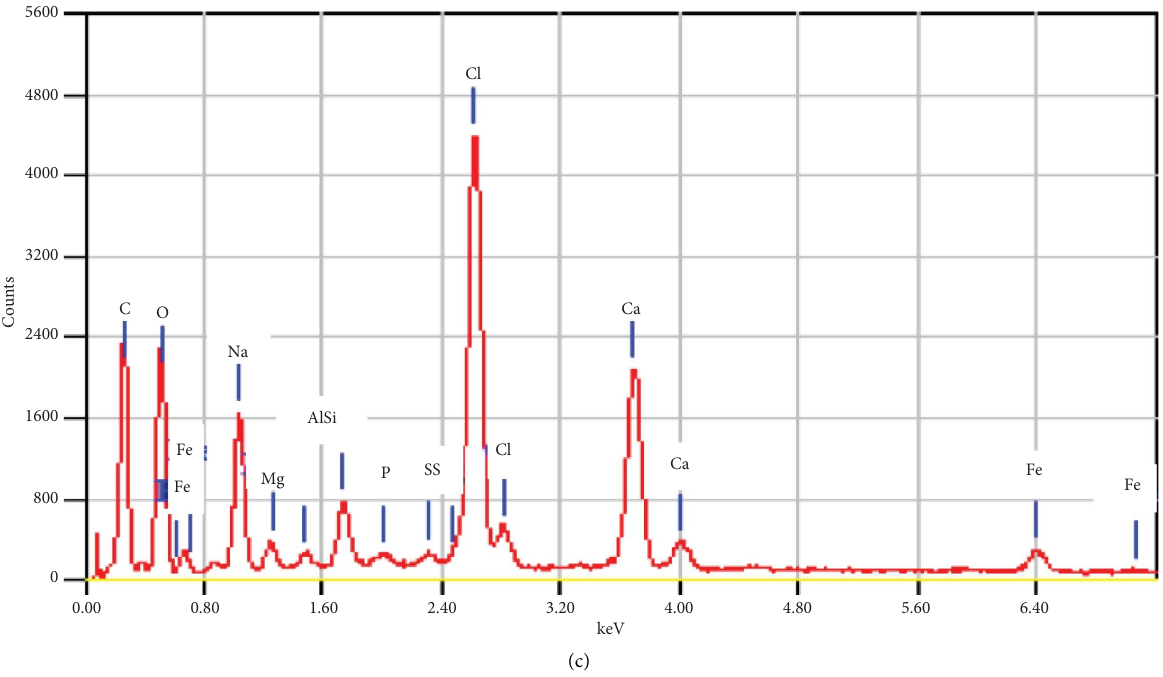
Figure 4: (a) EDX spectra of prepared chitosan. (b) EDX spectra of prepared chitosan. (c) EDX spectra of standard commercial chitosan [28].